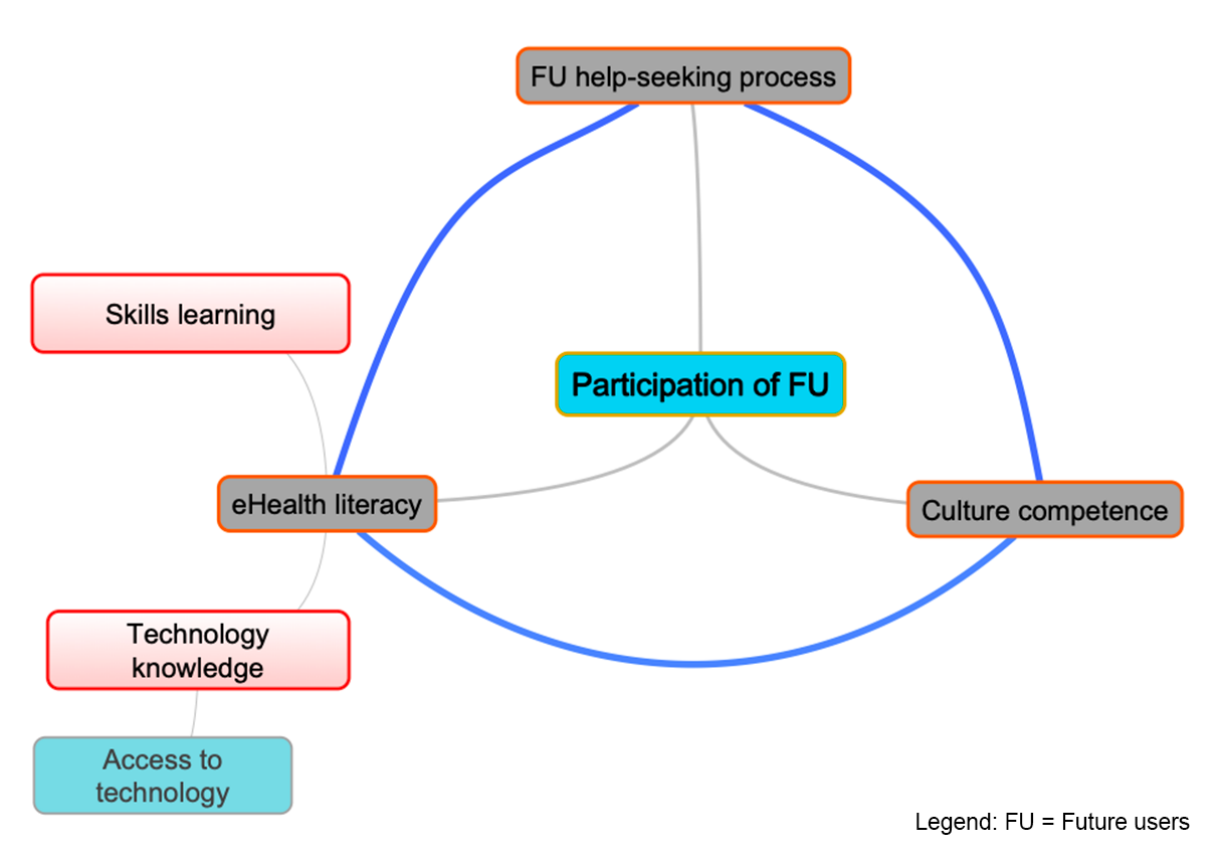
Figure 5. Relationship between conversion